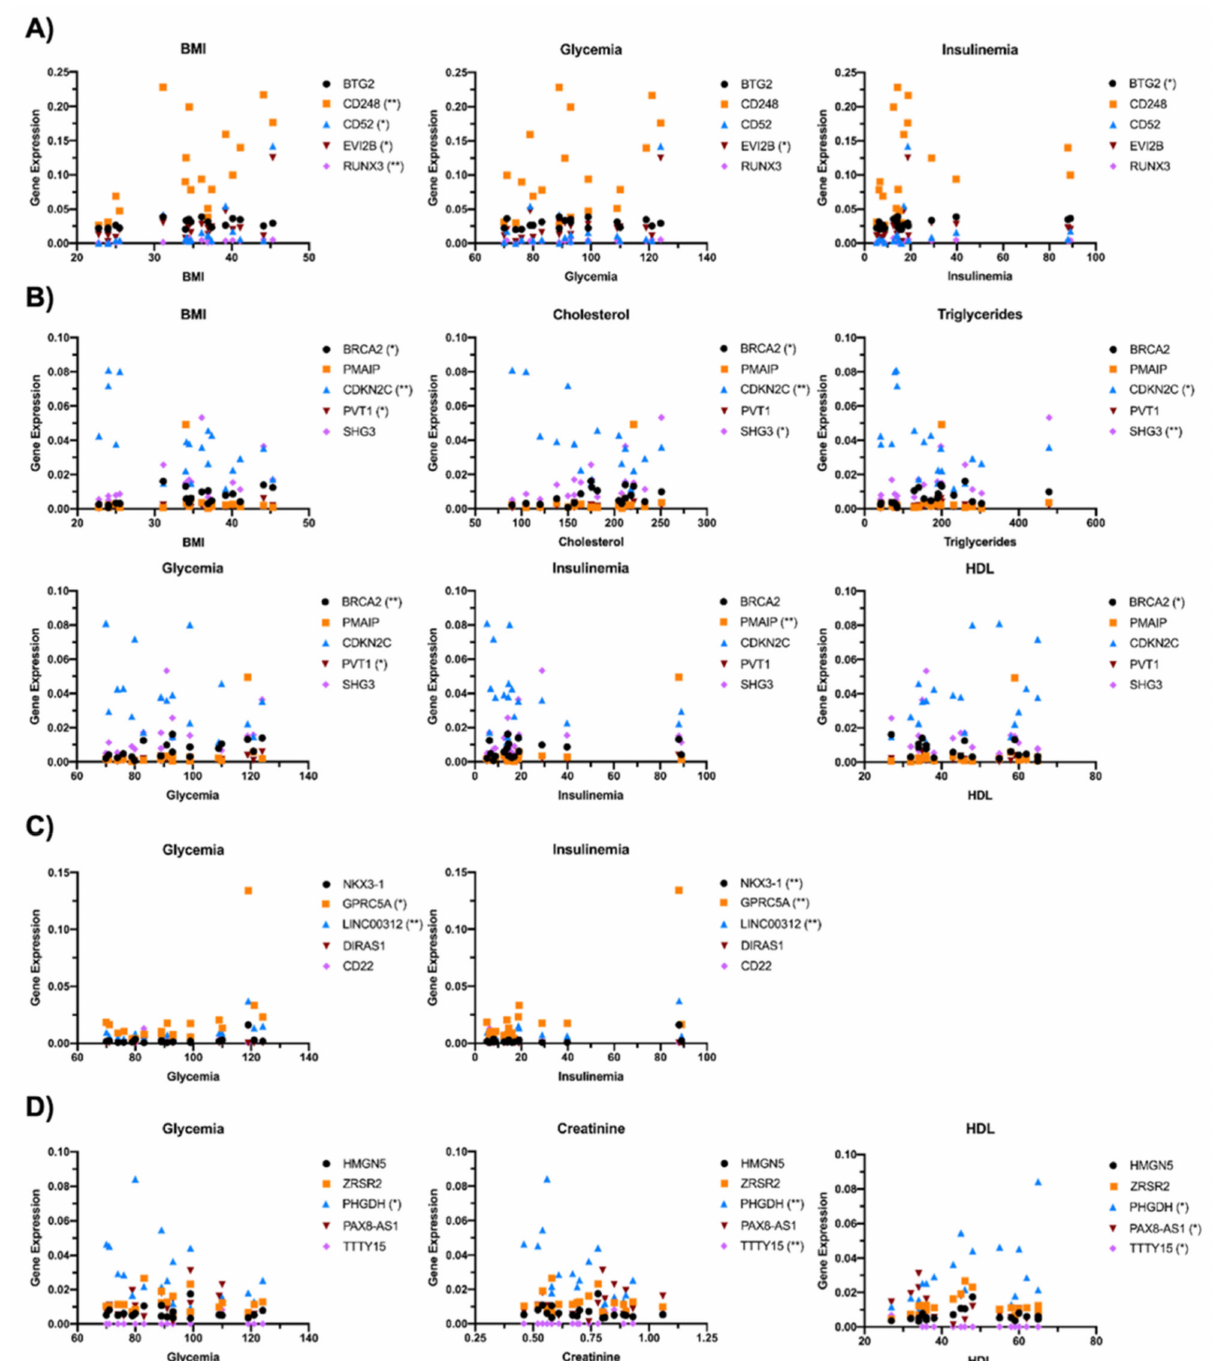
Figure 2. Correlation between the top 5 genes with the highest OncoScore and the subject’s anthropometrical parameters. The top 5 ranking oncogenes were correlated with Body Mass Index (BMI), cholesterol, triglycerides, glycemia, insulinemia, creatinine and High-Density Lipoproteins (HDL) ( A ) for obese women (OBF) vs. healthy controls (CTRL) (* p < 0.05; ** p < 0.01 vs. CTRL), ( B ) for obese women with type 2 diabetes (OBT2D) vs. CTRL (* p < 0.05; ** p < 0.01 vs. CTRL), ( C ) for OBT2D vs. OBF (* p < 0.05; ** p < 0.01 vs. OBF) and ( D ) for obese males (OBM) vs. OBF (* p < 0.05; ** p < 0.01 vs.